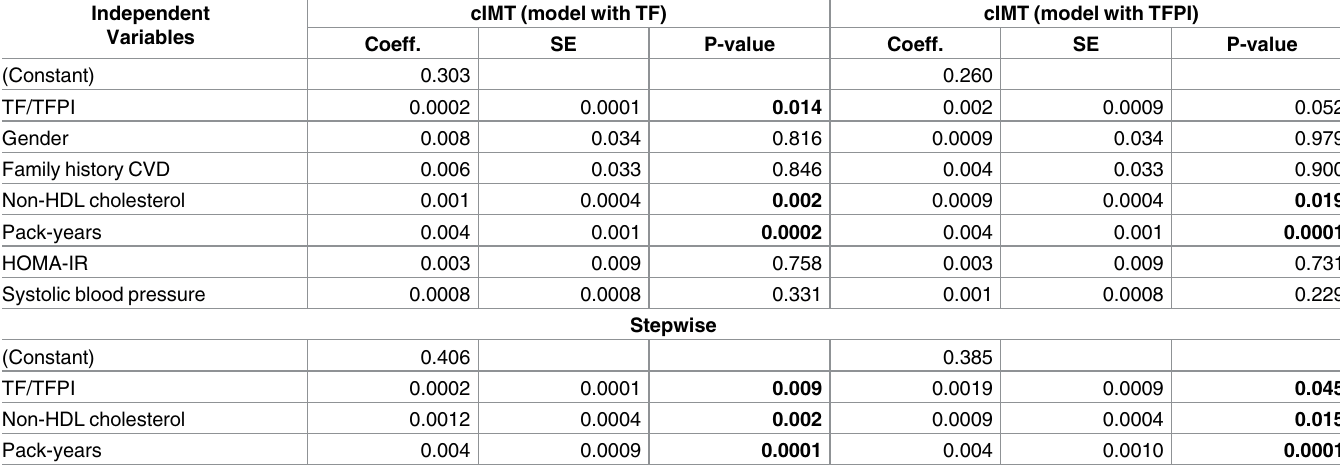
Table 5. Analysis of the effect of TF and TFPI and risk factors on cIMT (multivariate regression model). Independent Variables